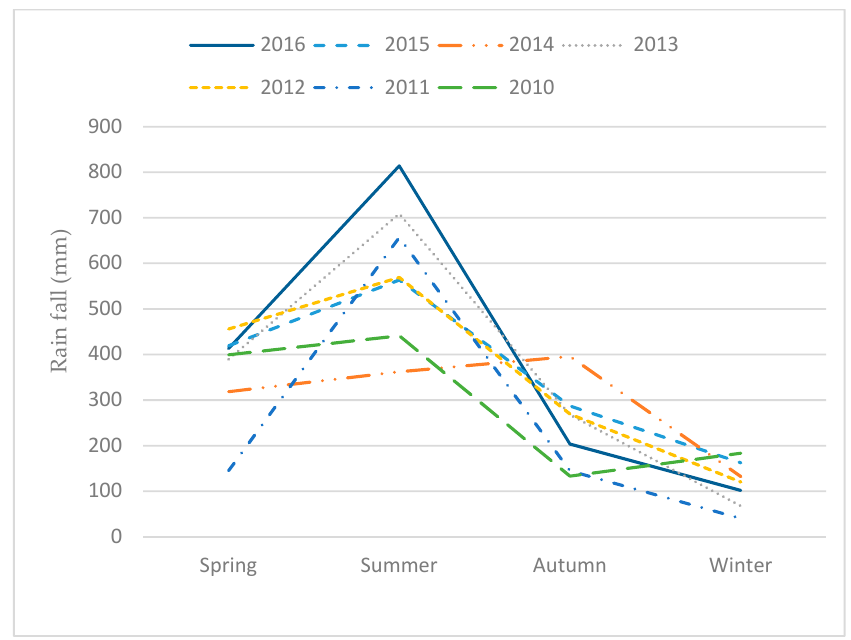
Figure 5. Historical rainfall of Hubei Province. Table 2. Flood data in Hubei Province.